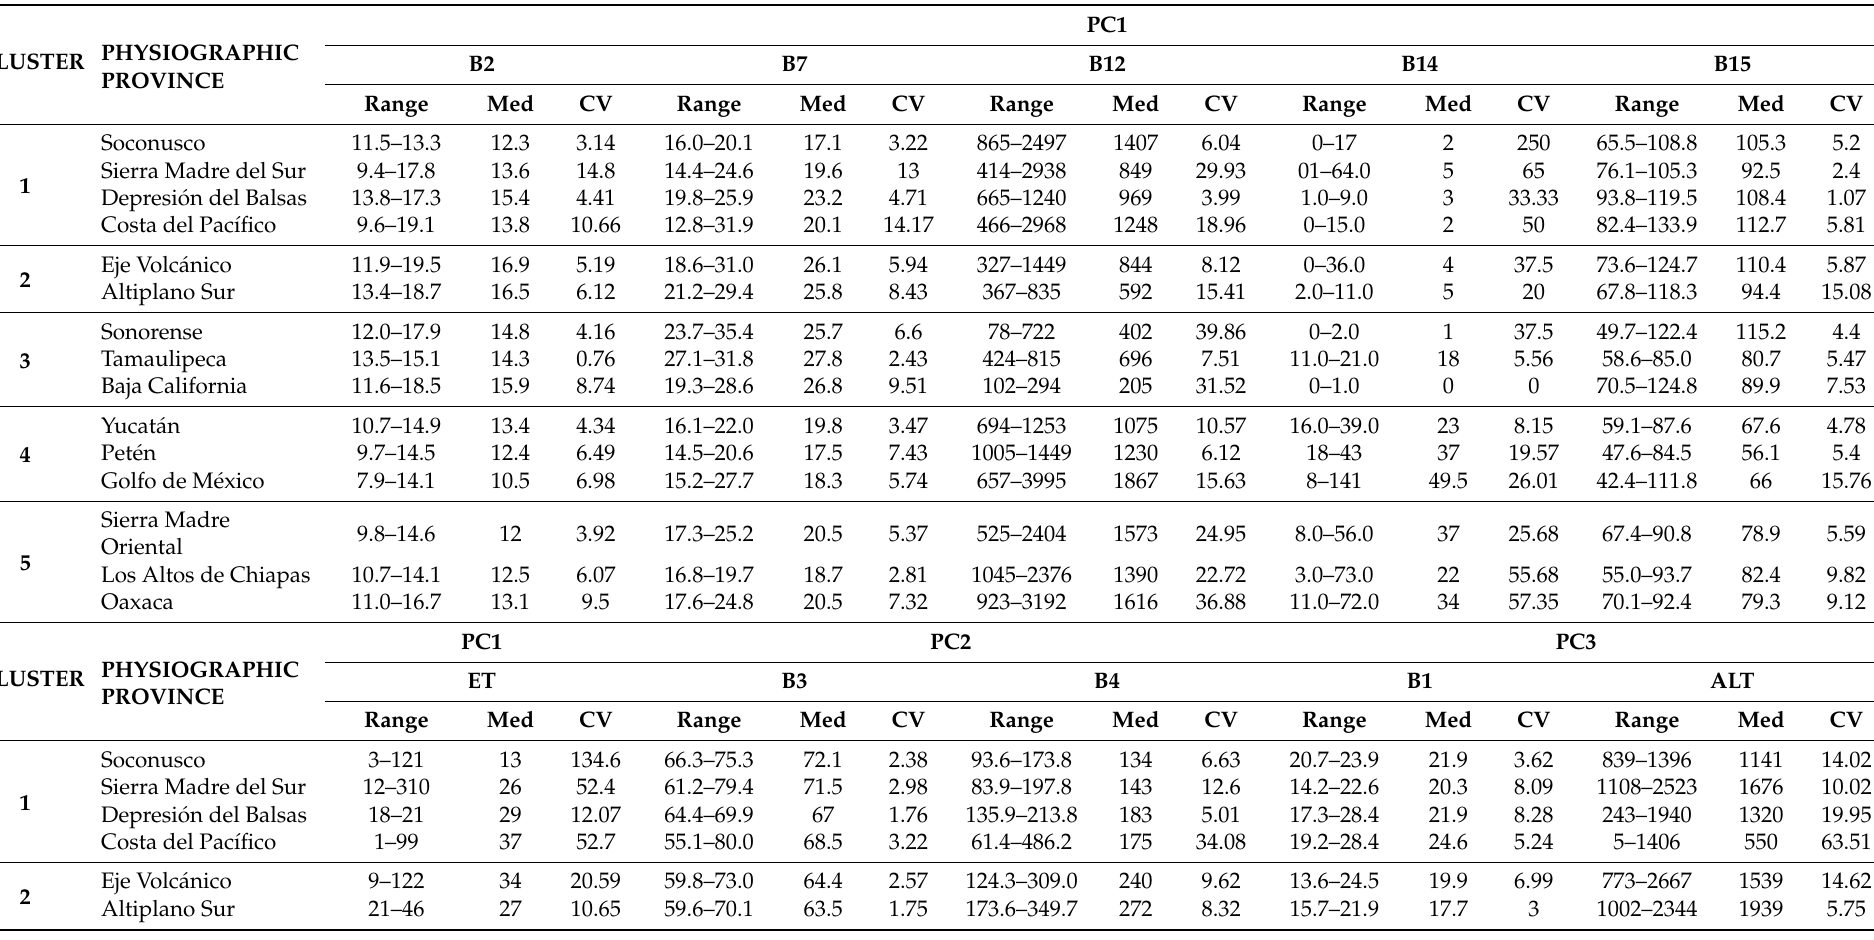
Table 1. Ecological descriptors of 10 climatic variables for S. lycopersicum L. distribution in Mexico according to physiographic provinces and cluster groups identified in CA. Range (Minimum–Maximum value), Med (Median), CV (Coefficient of variation), B1 (annual mean temperature), B2 (mean diurnal range), B3 (isothermality), B4 (temperature seasonality), B7 (temperature annual range), B12 (annual precipitation), B14 (precipitation of the driest month), B15 (precipitation seasonality), ET (annual evapotranspiration), and ALT (digital elevation